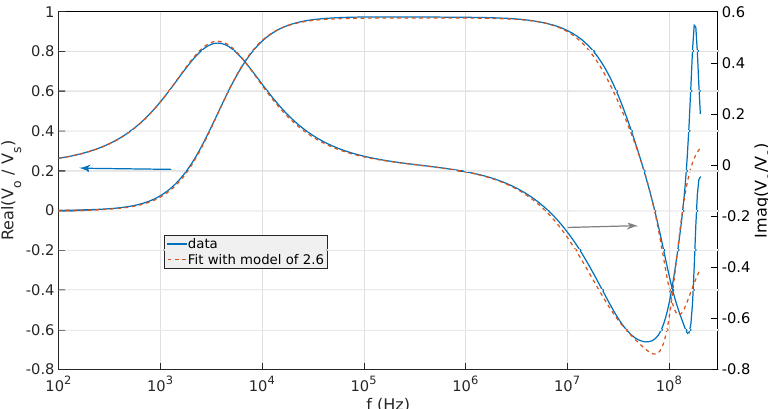
Figure 6. Measured real and imaginary parts of the transfer function of the transformer, fitted with the model of Figure 5 and Equation (7). The continuous lines are measured data, while the dash-dot lines are the fitting